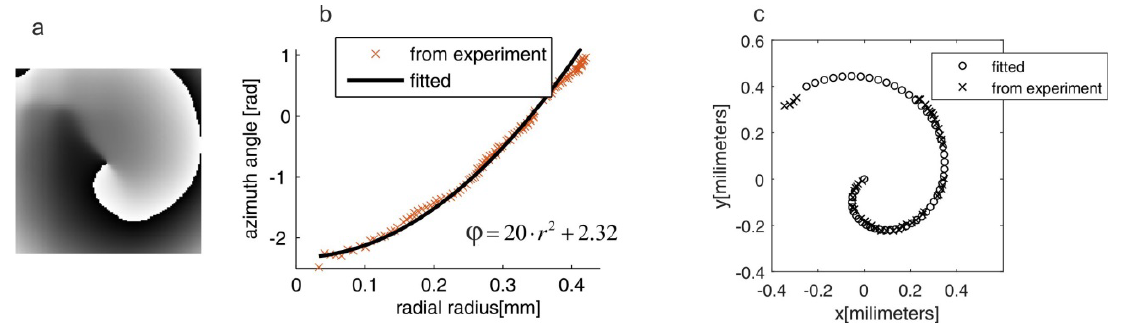
Figure 10. ( a ) The phase map obtained from the experiment; ( b ) Polar coordinates of the edge position extracted from (a) and the fitted line; ( c ) Fermat’s spiral fitted to the experimental data-crosses denote the 2 π jump line from (a ), circles indicate the fitted spiral.